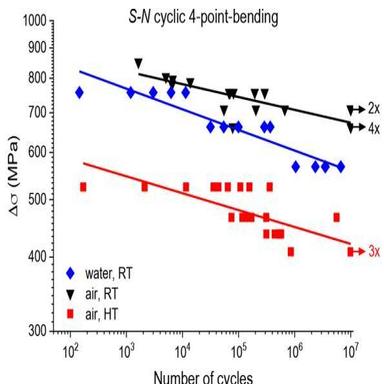
S-N curves from cyclic fatigue tests on bend bars in 4PB at RT and 1000 °C.